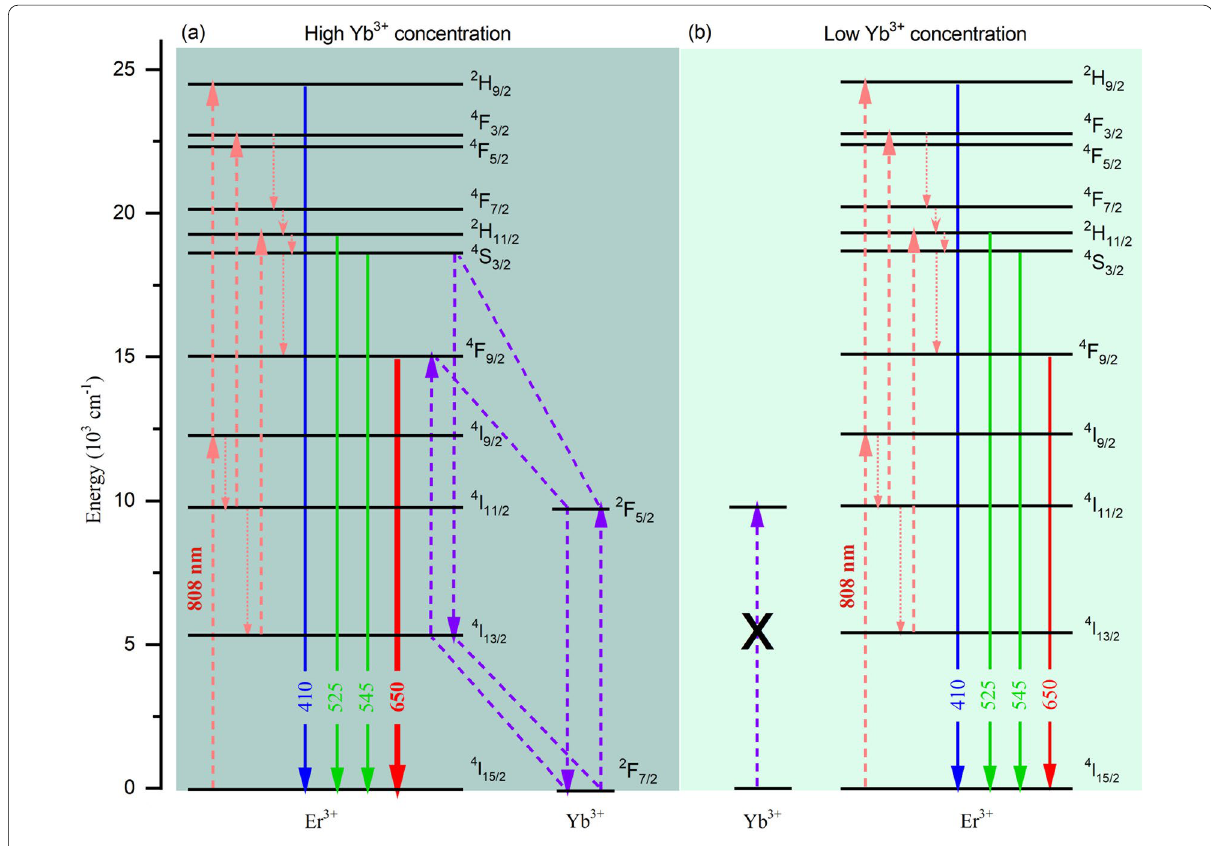
Fig. 5 The proposed energy level diagram for a highly Yb 3 + -doped and b lowly Yb 3 + -doped β-NaYbF 4 :2%Er microcrystals, the corresponding mechanism of ET processes, radiative and non-radiative transitions are also